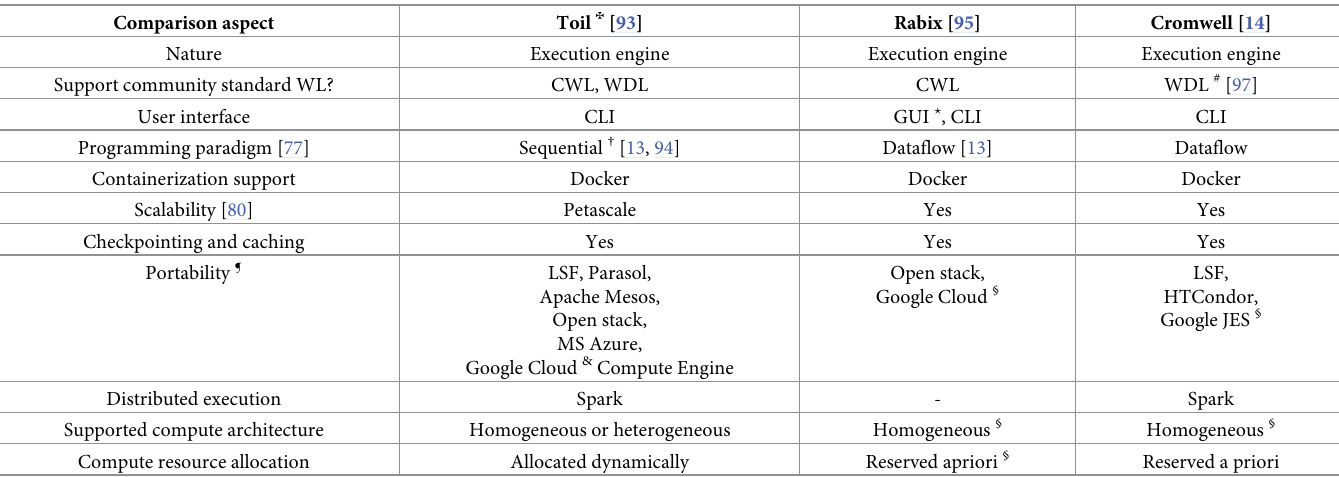
Table 4. Popular workflow management